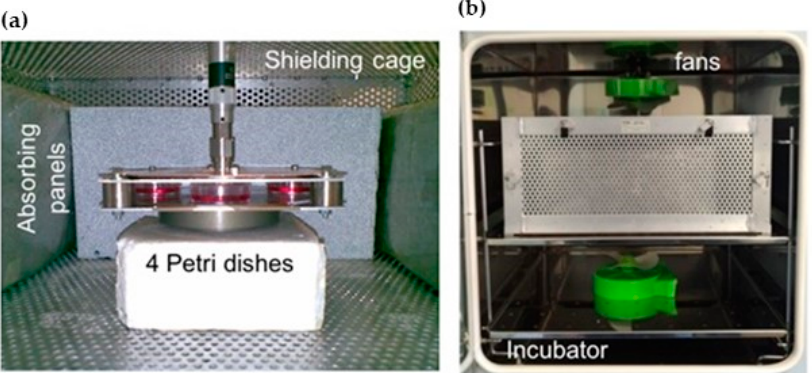
Figure 6. Picture of the WPC with the four Petri dishes inside. ( a ) WPC placed into the shielding cage with the lateral walls covered with absorbing panels. ( b ) Shielding cage inside the incubator with the two fans used to induce a forced air flow for temperature control.